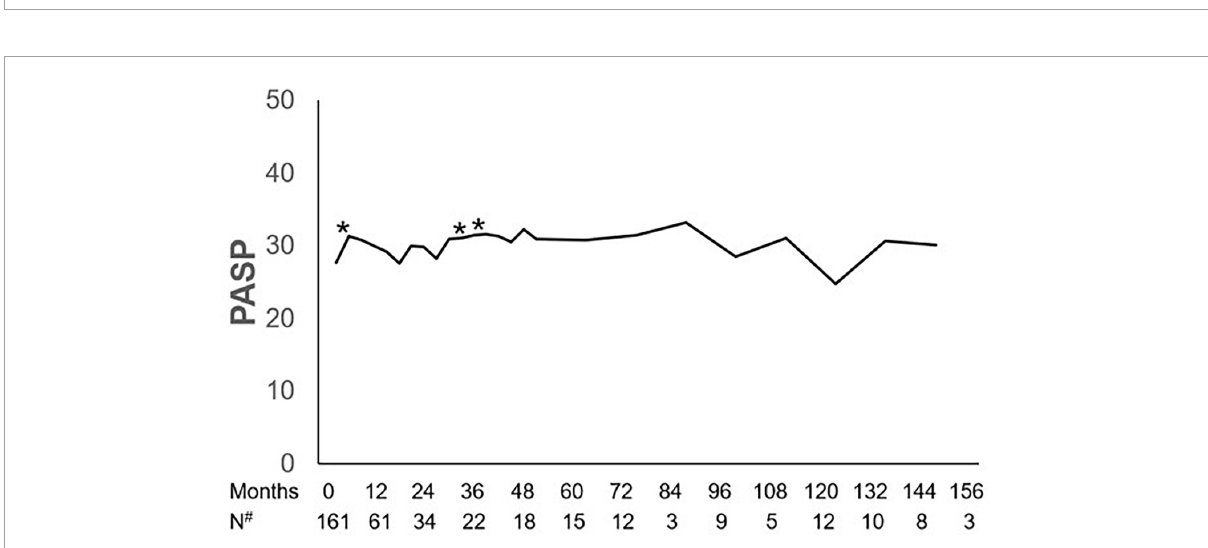
FIGURE3 Dynamics of PASP. Pulmonary artery systolic pressure (PASP) at 3, 30, and 36 months during dasatinib-therapy was significantly higher than that at baseline. * P-value < 0.05 compared with baseline. # Number of subjects who had echocardiographic data during the